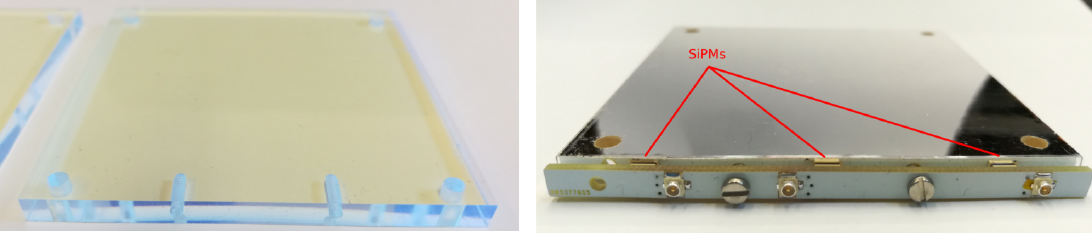
Figure 5. The bare scintillator is wrapped with a specular reflector foil and is populated with three SiPMs on a PCB.